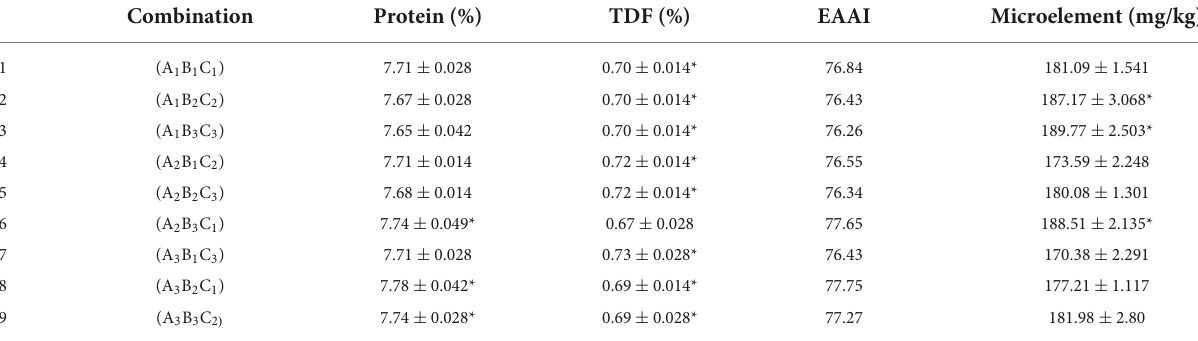
TABLE 4 Nutritional characteristics of different rice flour with different